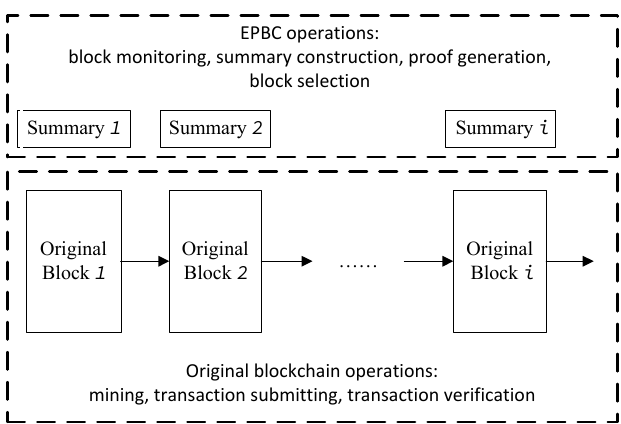
Figure 4. Overview of the integration of EPBC with an existing blockchain systems. A dedicated client is used to support EPBC related operations.